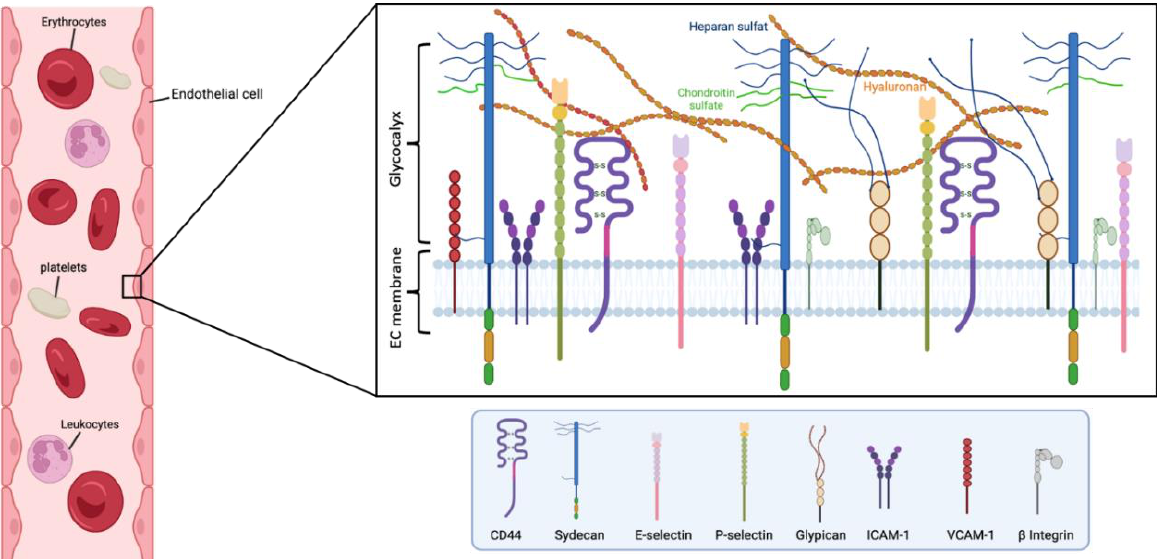
Figure 1. Main components of the human endothelial glycocalyx. The eGC consists of proteoglycans, glycoproteins, and glycosaminoglycans, associated with plasma proteins. Among others, CD44 is a cell-surface receptor for HA, it plays an important role in cell proliferation, and migration, and participates in vascular barrier integrity via the regulation of CD31 expression. β Integrin participates in leukocyte homing and subsequent diapedesis, and platelet interactions via a link to collagen, fibronectin, and laminin in the subendothelial matrix. P-selectin and E-selectin are implicated in the ‘tethering’ and rolling’ of leukocytes in stimulated‘ endothelial cells. Particularly, E-selectin needs direct stimulation by cytokines such as IL-1, TNF- α, or LPS for production and surface expressio. Syndecans and glypicans are proteoglycans that contain GAG chains such as HS and CS. Moreover, syndecans represent the principal effector in cell adhesion or shape changes by their interaction with the cytoskeleton, while the glypicans have a role in flow-induced endothelial NO synthase activation. The intercellular adhesion glycoprotein (ICAM-1) is expressed in the endothelial cell surface participating in cell-to-cell interactions and facilitates leukocyte endothelial transmigration. VCAM-1 is a glycoprotein which contributes to the cell adhesion of molecules to the endothelium. Figure created with BioRender.com.